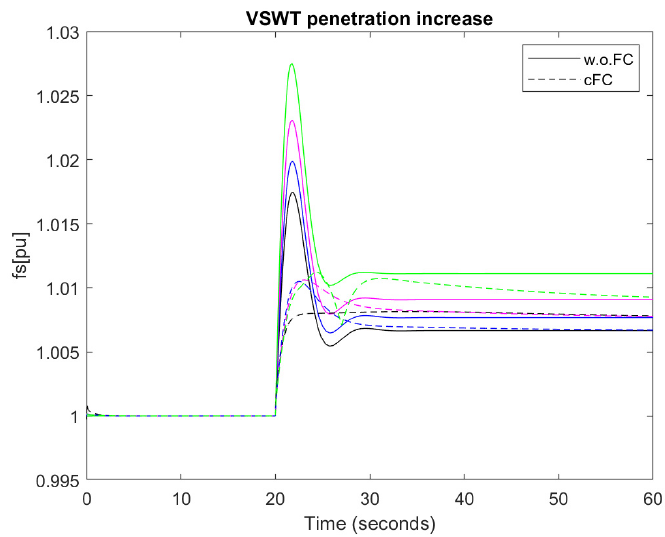
Figure 22. VSWT penetration